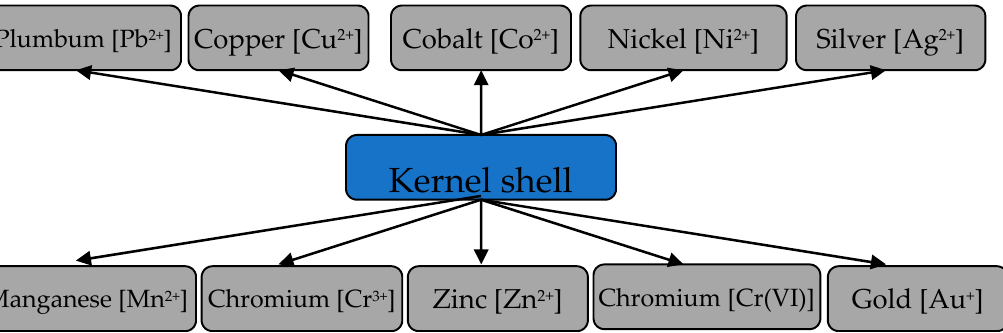
Figure 10. Some metals extracted from aquatic environments with activated carbon from apricot kernel shells.